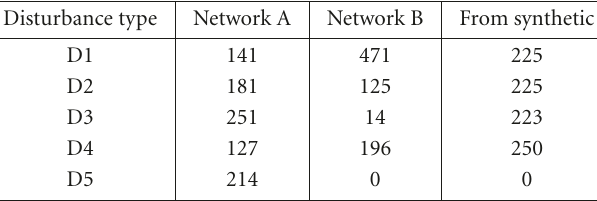
Figure 18: The decision boundaries and support vectors obtained by training an SVM with Gaussian RBF kernel functions. Solid line: the decision boundary; dashed lines: the margins. (a) The parame- ter for RBF kernels is γ = 36 m 0 ; (b) the parameter for RBF kernels is γ = 8 m 0 . For both cases, the regularization parameter is C = 10, and m 0 = 2 is the size of the input vector. Solid line is the deci- sion boundary. Support vectors are the training vectors that are lo- cated on the margins (the dotted lines) and in between the bound- ary and the margin (misclassified samples). For the given training set, there is no misclassified samples. The two sets of feature vectors are marked with rectangular and circles, respectively. Notice that only support vectors are contributed to the location of the decision boundary and margins. In the figure, all feature values are scaled by a factor of 10. Table 3: Number of voltage recordings used.